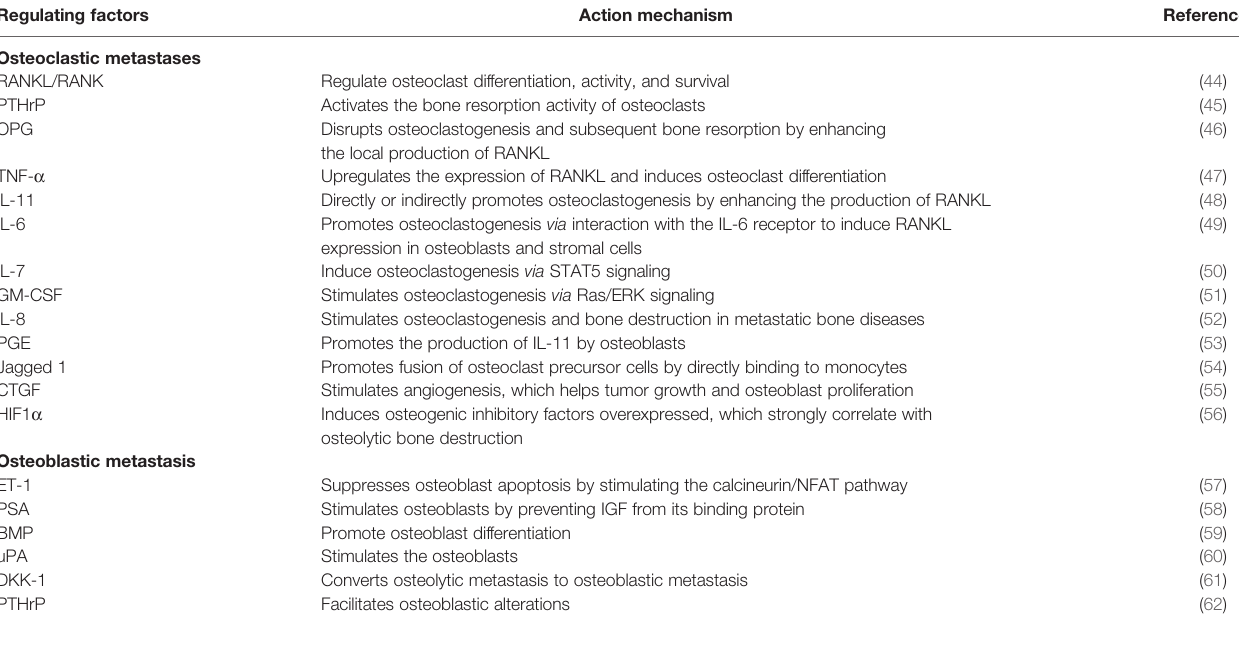
TABLE 1 | Regulating factors associated with the bone metastasis